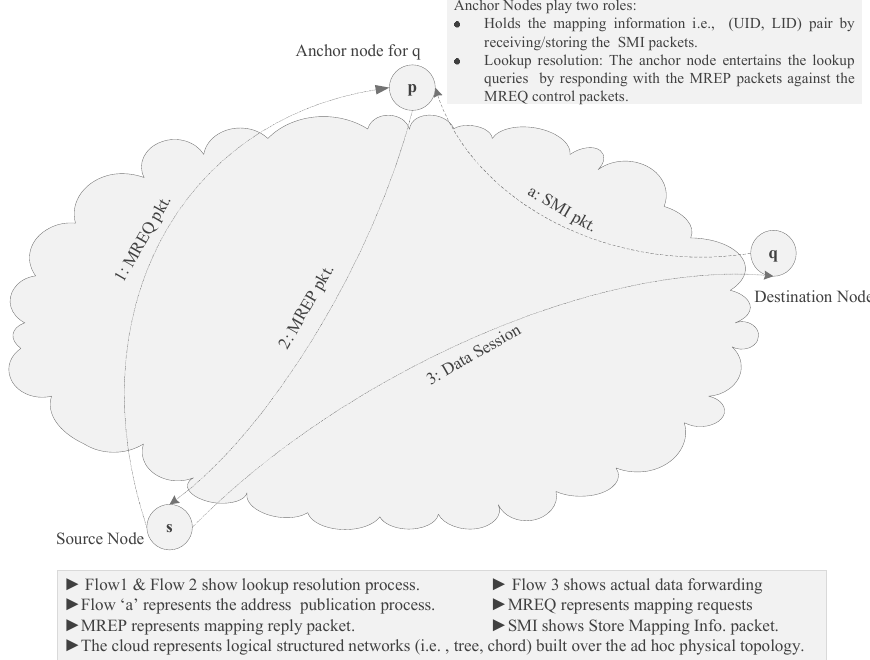
Figure 1. Address publication, lookup, and routing in DHT